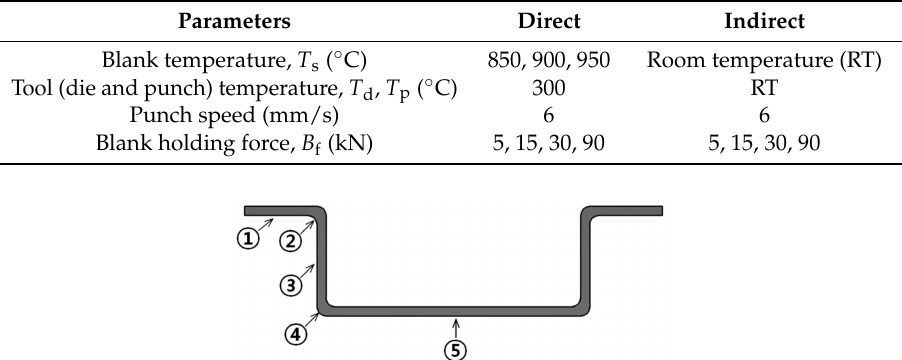
Figure 4. Position for the measurement of the thinning rate, microstructures and Vickers